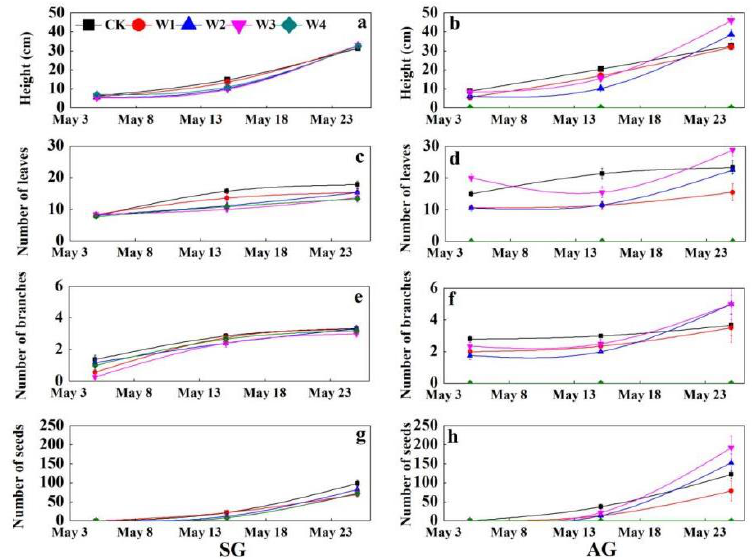
Figure 2. Effects of extreme precipitation on height ( a , b ), leaf number ( c , d ), branch number ( e , f ), and seed number ( g , h ) of spring-germinated (SG) plants and autumn-germinated (AG) plants of Erodium oxyrhynchum . ( a ), Plant height of SG; ( b ), plant height of AG; ( c ), leaf number of SG; ( d ), leaf number of AG; ( e ), branch number of SG; ( f ), branch number of AG; ( g ), seed number of SG; ( h ), seed number of AG. CK, control treatment; W1, +30% increase in precipitation; W2, +100% increase in precipitation; W3, +200% increase in precipitation; W4, maintenance of field capacity by increas- ing precipitation every three days.